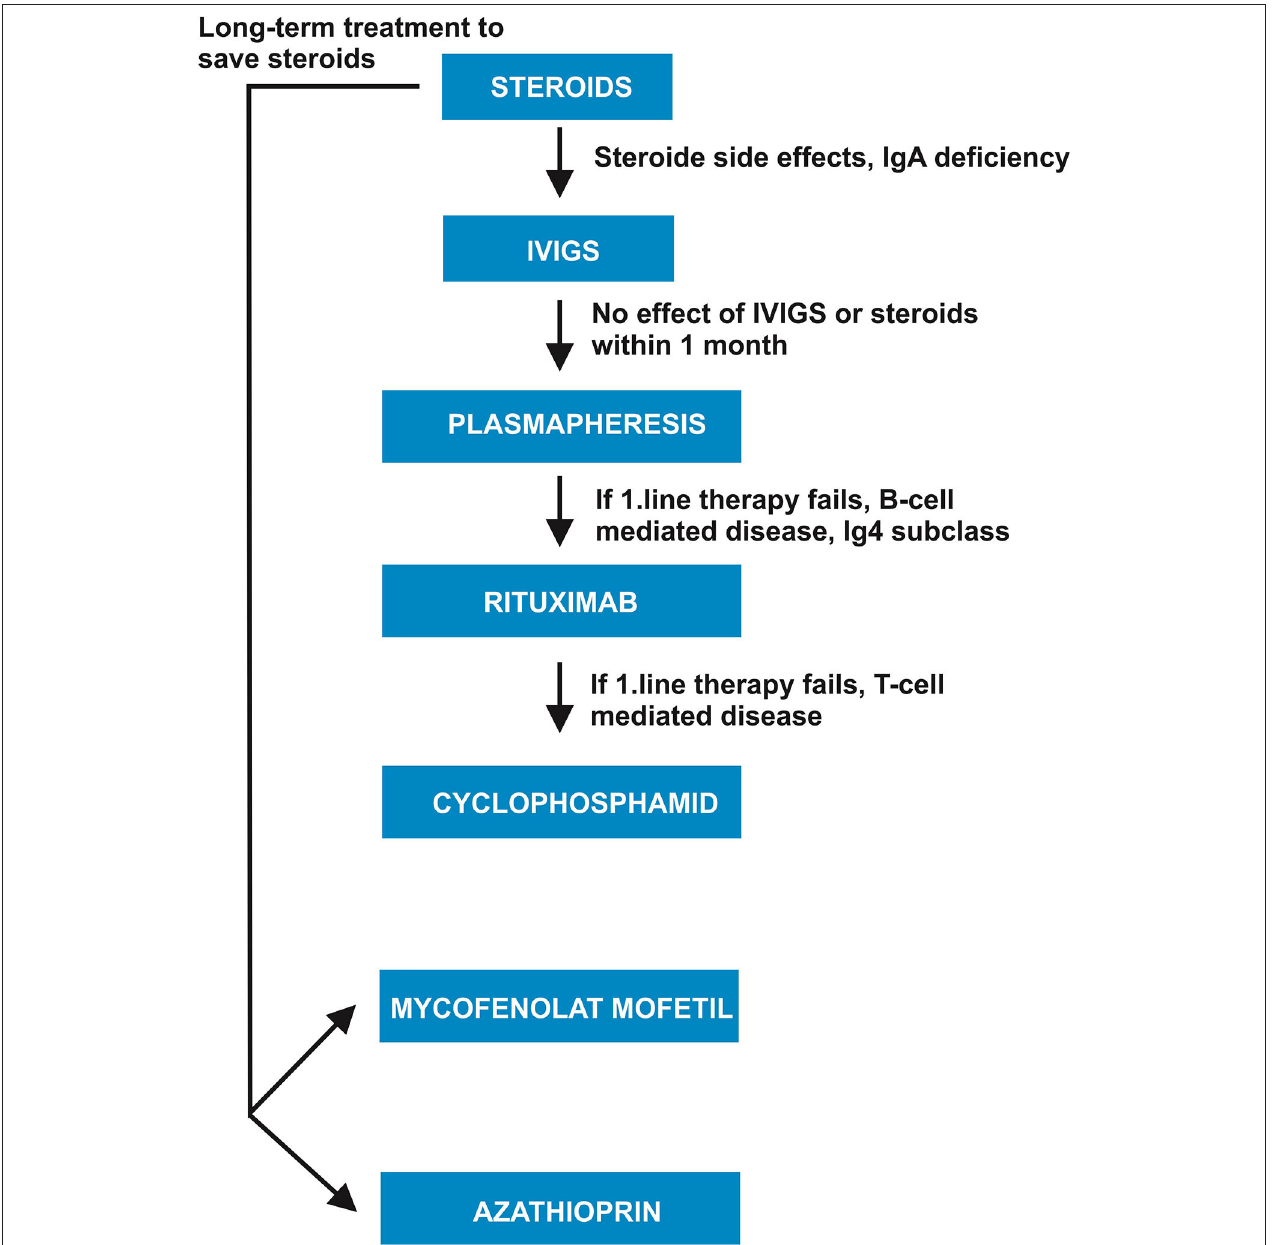
FIGURE 1 | Clinical pathway for selecting immunotherapy for autoimmune-based psychiatric syndromes. IVIGS/s, intravenous immunoglobulins; IgA, immunoglobulin A; IgG4 subclass, immunoglobulin G4